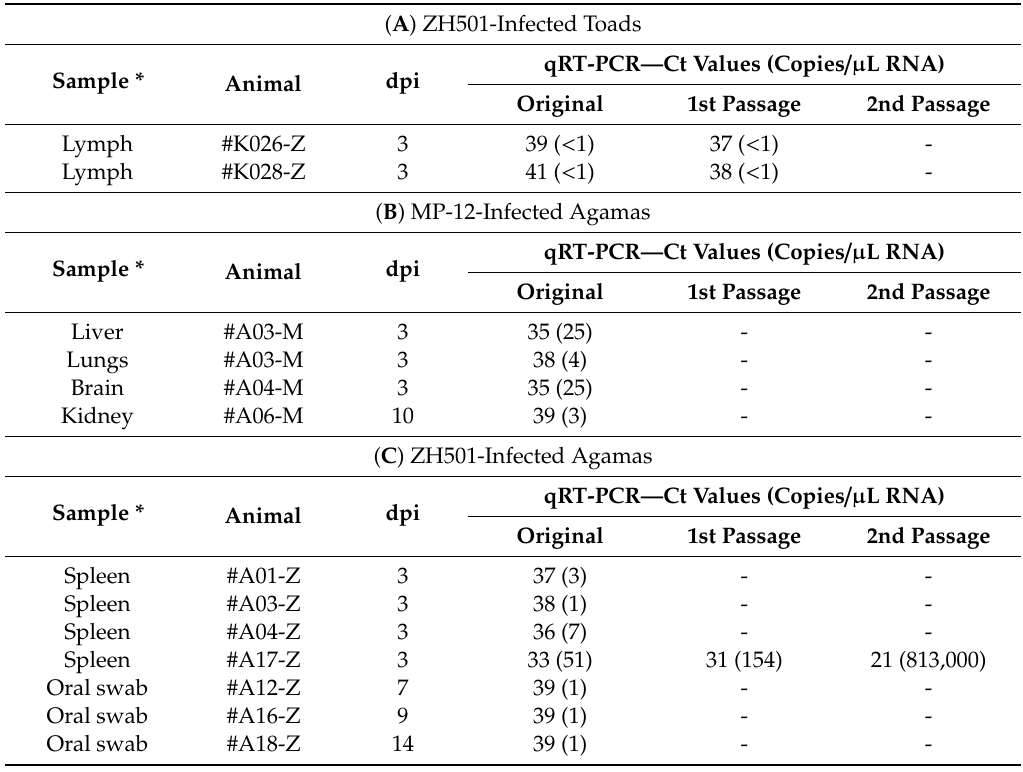
Table 2. Detection of viral